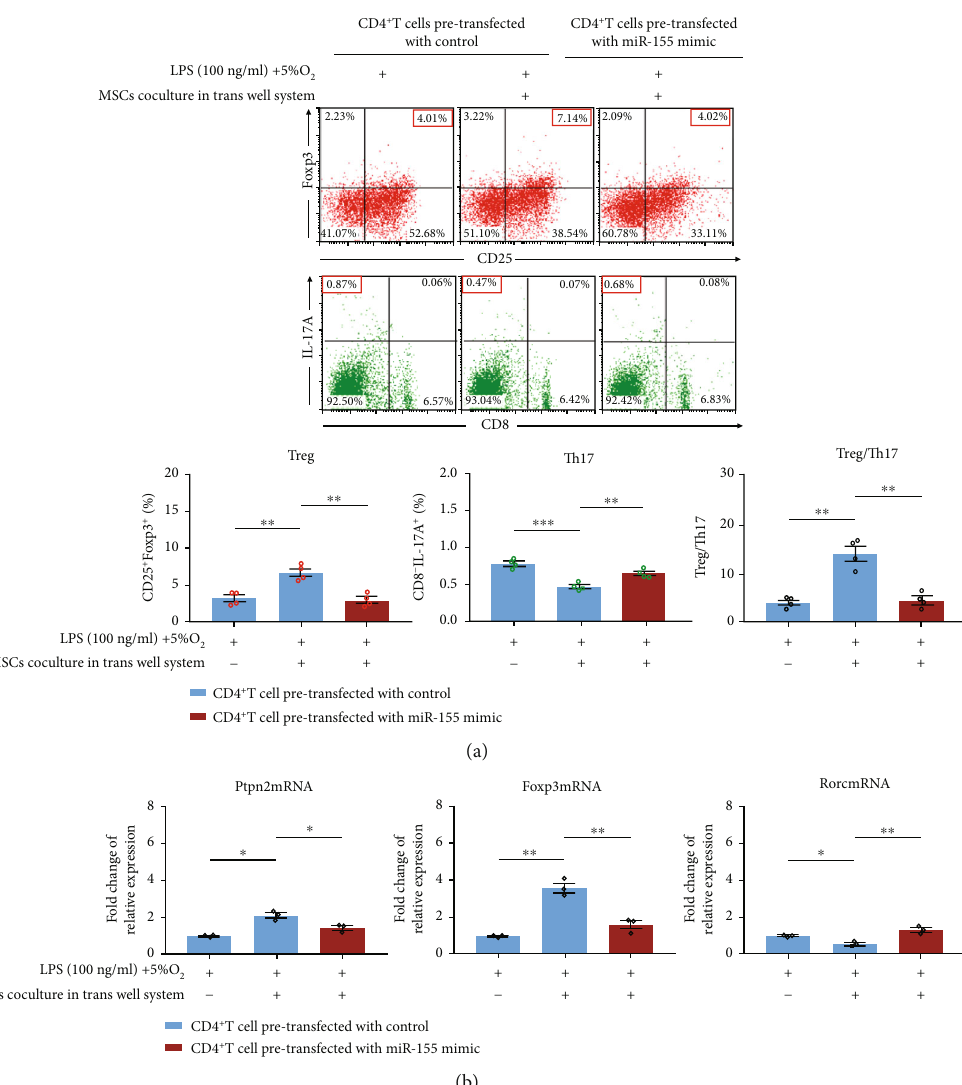
Figure 6: E ff ects of miR-155 overexpression in CD4 + T cells on LPS-hypoxia-induced Treg/Th17 skewing and related gene expression in response to MSC treatment. CD4 + T cells pretransfected with control/miR-155 mimic received MSC treatment by transwell system, with/ without LPS-hypoxia challenge for 48 hours. (a) Then, cells were harvested for Treg and Th17 phenotypic identi fi cation by fl ow cytometry. Representative fl ow plots were shown. Bar graphs represent mean frequency ± SEM of Treg and Th17 and mean values ± SEM of Treg/Th17 ratios in the various groups. (b) The gene expression of Ptpn2, Foxp3, and Rorc mRNA of CD4 + T cells was detected by RT-PCR in the various groups. Bar graphs represent mean ± SEM levels of Ptpn2, Foxp3, and Rorc mRNA expression. Blue bar graphs present gene expression in CD4 + T cells pretransfected with control, and red bar graphs present gene expression in CD4 + T cells pretransfected with miR-155 mimic. ∗ P < 0 : 05 , ∗∗ P < 0 : 01 , and ∗∗∗ P < 0 : 001 ( n = 4 ). LPS: lipopolysaccharide; MSC: mesenchymal stem cell; RT-RCR: real-time polymerase chain reaction; SEM: standard error of the mean; Th: T helper; Treg: regulatory T